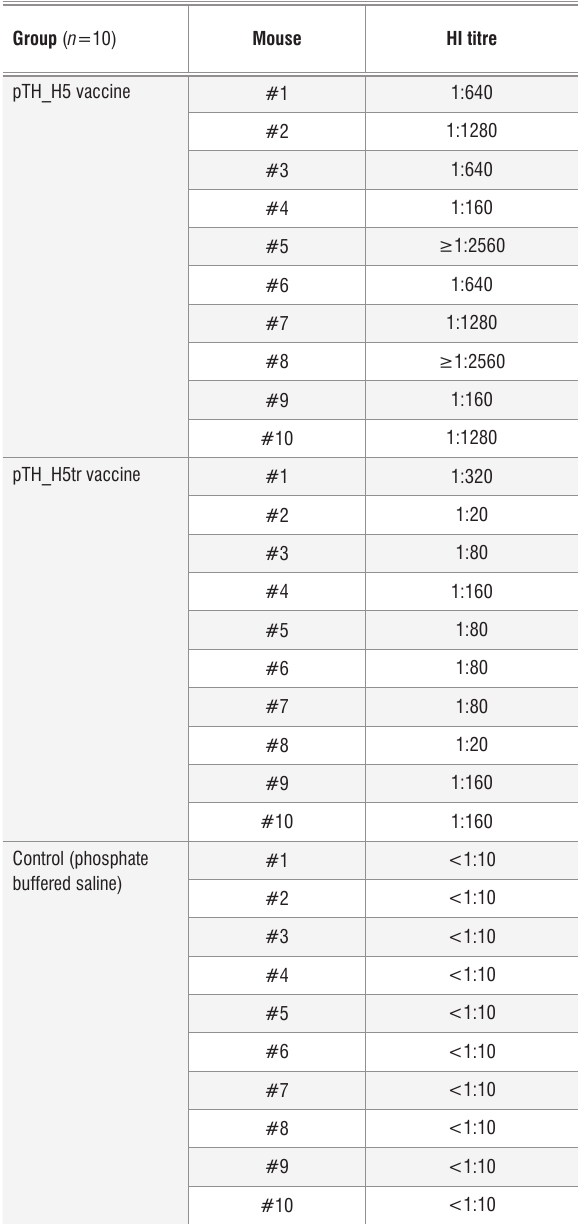
Group ( n =10) Mouse HI